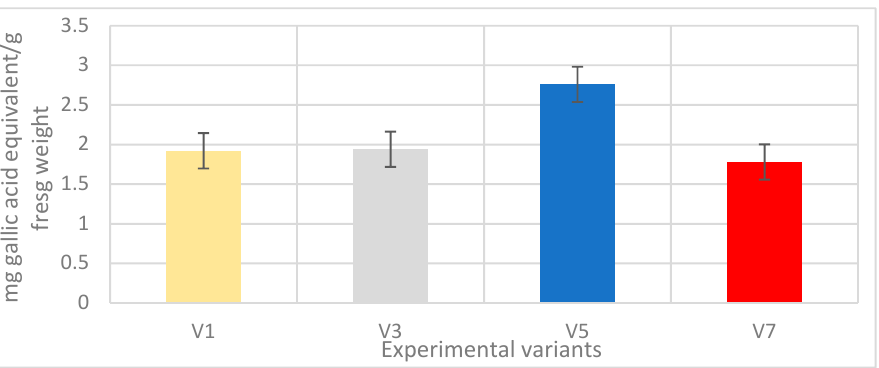
Figure 4. The polyphenol contents in Lepidium sativum L. sprouts on gauze substrate (V1 control, illuminated with sunlight; V3, illuminated with white LED; V5, illuminated with blue LED; and V7, illuminated with red LED experimental variants). Data acquired from the experiment were statistically investigated and are expressed as the mean ± SD (standard deviation). Bars are one standard deviation. Table 4. A one ‐ way ANOVA test for the polyphenols in Lepidium sativum L. sprouts’ weight.